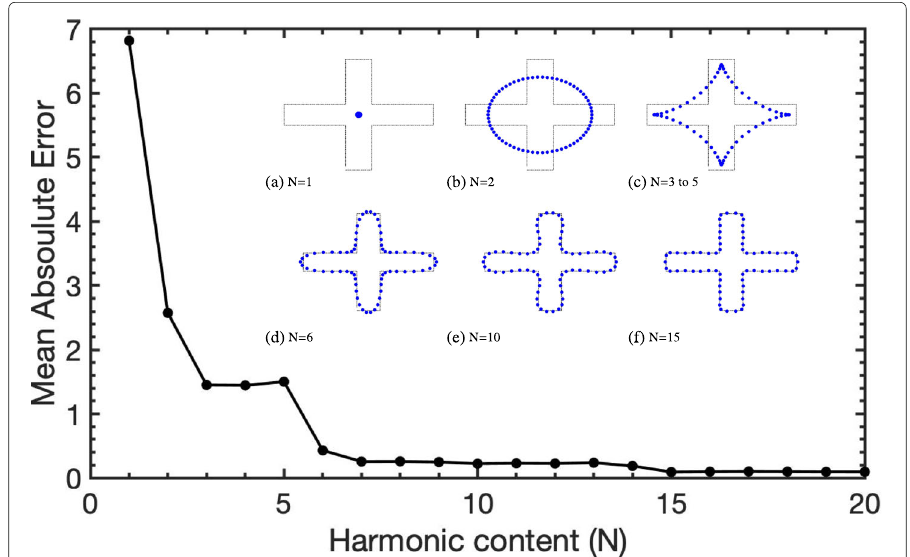
Fig. 3 Representation of a cross shape using different number of FDs. The level of detail captured by increasing the number of descriptors. Blue points show the reconstructed